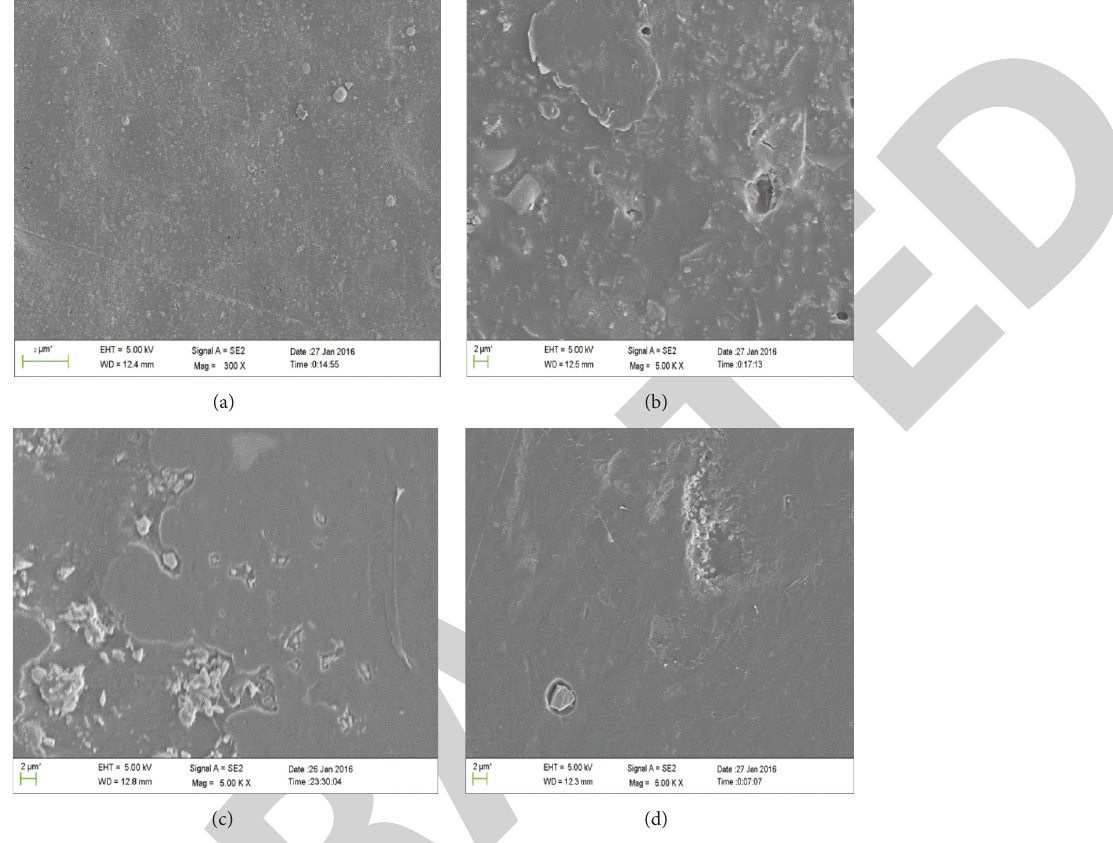
Figure 2: SEM images for different wt% ratios of composite polymer electrolyte